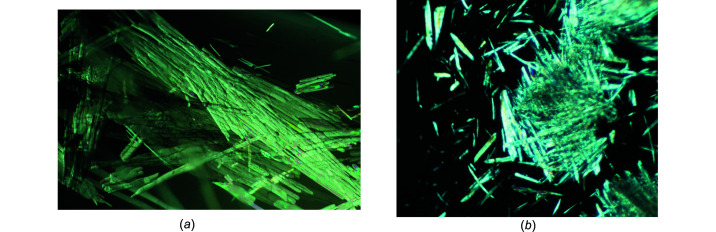
The crystals of (a) NaOnPr·2nPrOH (image width about 15 mm) and (b) NaOtAm·tAmOH (image width about 2 mm), both in polarized light.